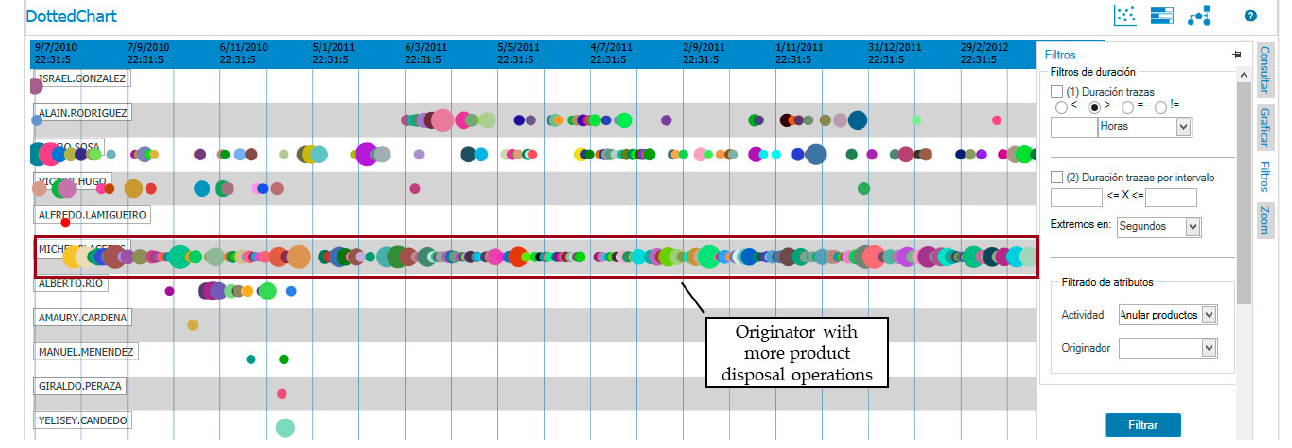
Figure 9. View by the originator of the executed product suppressions.